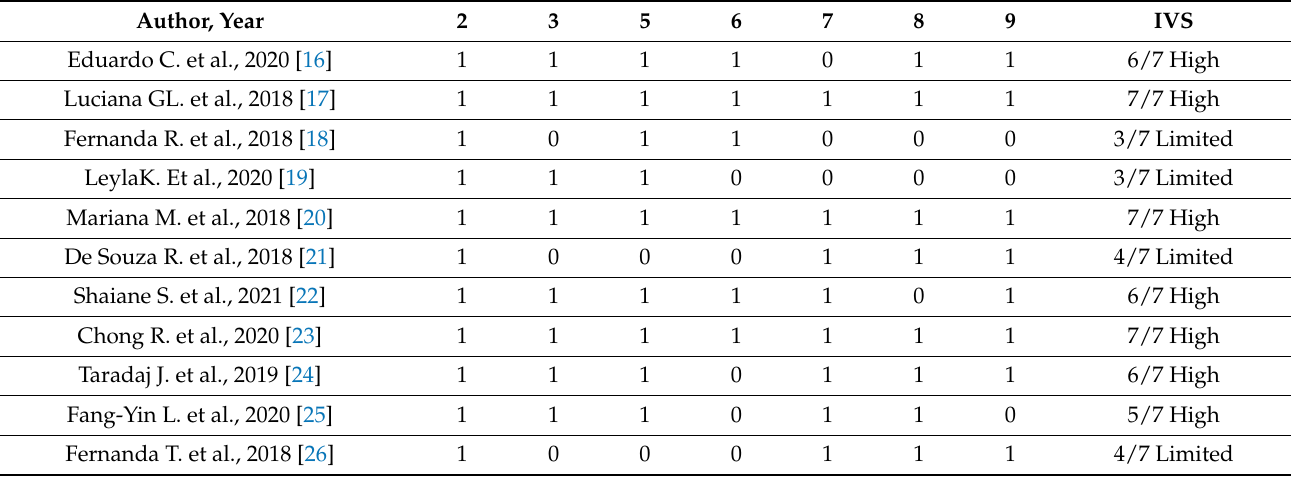
Table 3. Internal validity of the selected